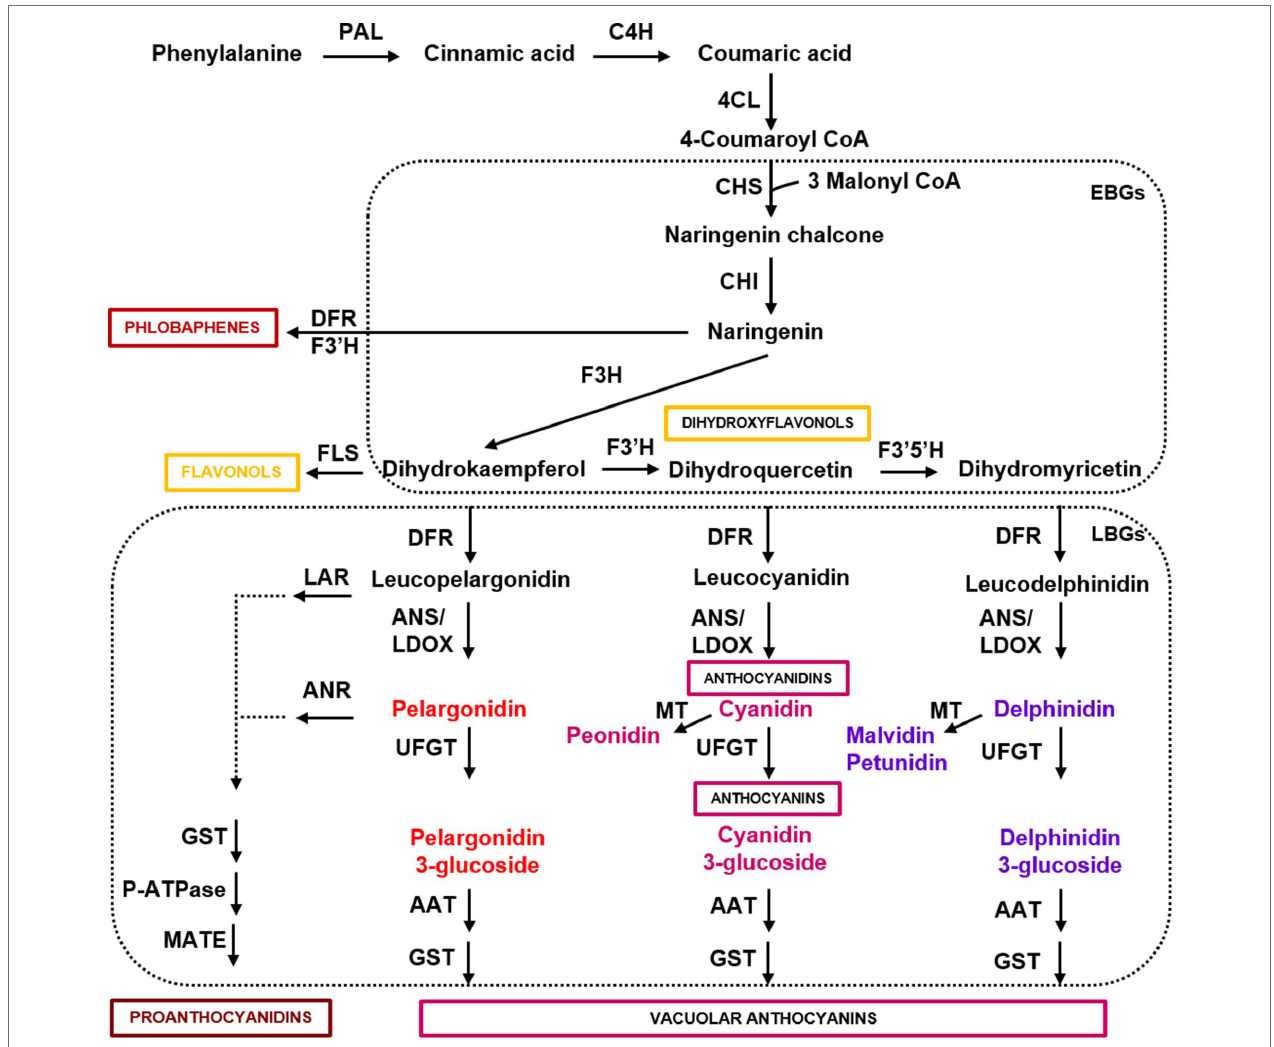
FIGURE 1 | Simplified scheme of the flavonoid pathway, comprising the general phenylpropanoid pathway, the anthocyanin branch, and other subgroups of flavonoid end-products. Enzyme names are abbreviated as follows: PAL, phenylalanine ammonia lyase; C4H, cinnamic acid 4-hydroxylase; 4CL, 4 coumarate CoA ligase; CHS, chalcone synthase; CHI, chalcone isomerase; F3H, flavanone 3-hydroxylase; F3 ʹ H, flavanone 3 ʹ -hydroxylase; F3 ʹ 5 ʹ H, flavanone 3 ʹ 5 ʹ -hydroxylase; DFR, dihydroflavonol reductase; FLS, flavonol synthase; ANS/LDOX, anthocyanidin synthase/leucoanthocyanidin dioxygenase; UFGT, UDP-flavonoid glucosyl transferase; ANR, anthocyanidin reductase; LAR, anthocyanidin reductase; MT, methyltransferase; AAT, anthocyanin acyltransferase; GST, glutathione S-transferase; P-ATPase, P-type ATPase proton pump; MATE, MATE-type transporter. Boxes indicate the early and late biosynthetic genes (EBGs and LBGs) of the flavonoid pathway in